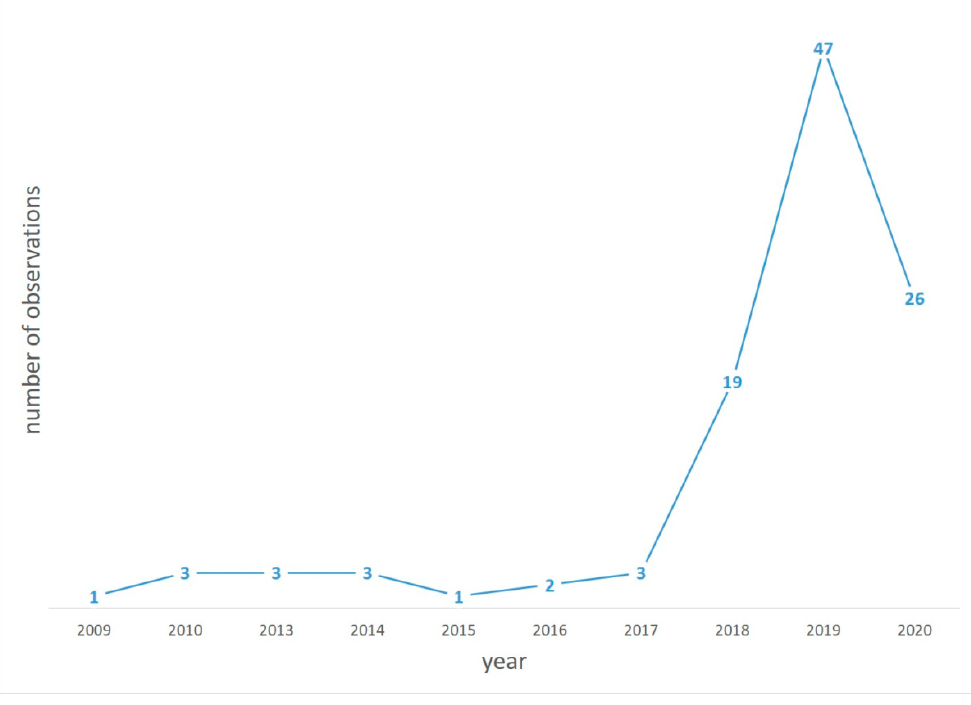
Figure 2. Number of observations of D. viscosa in the Republic of Croatia from 2009 to 2020.